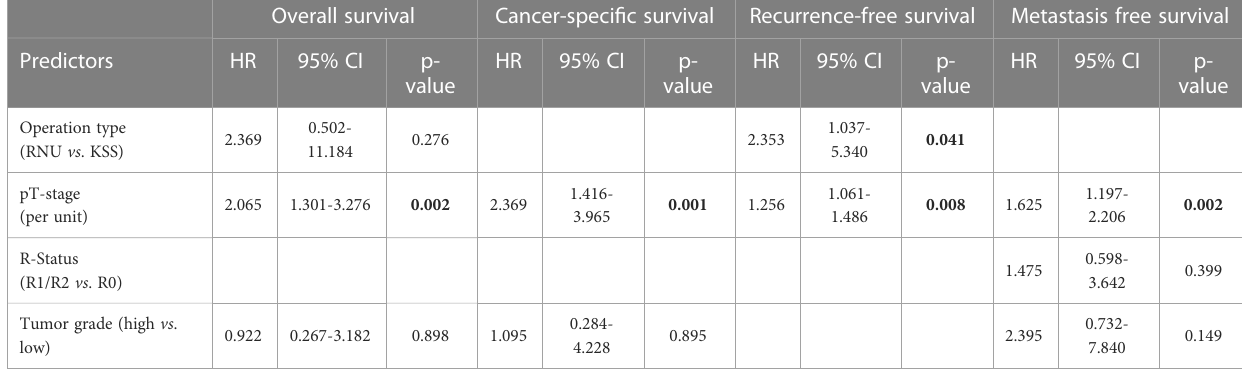
TABLE 4 Multivariably adjusted predictors for patient survival; HRs estimated with Cox proportional hazards regression